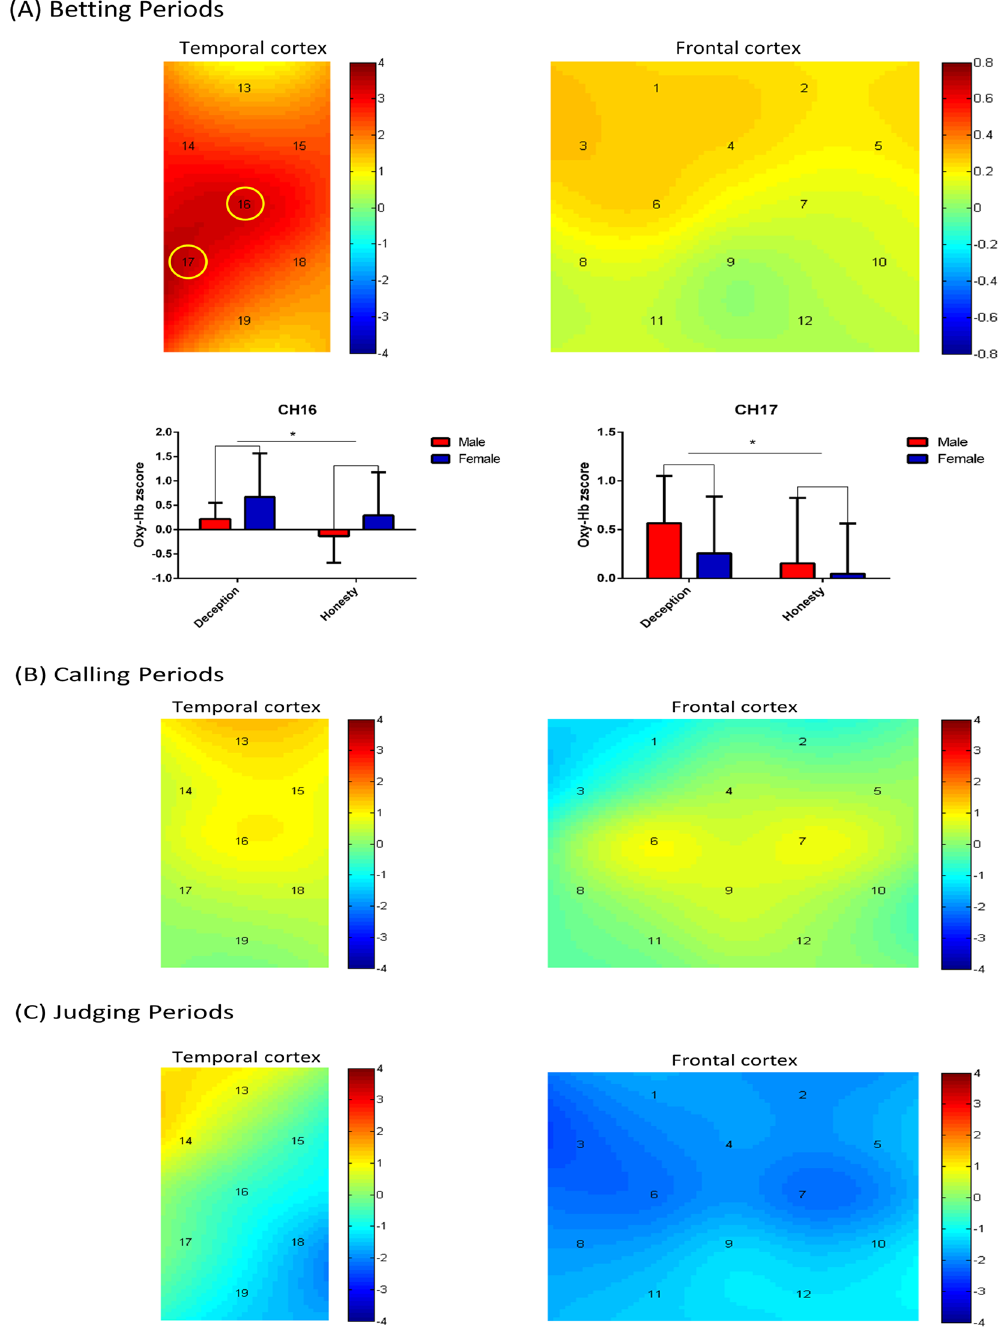
Figure 2. One-sample t-test of banker’s Oxy-Hb changes (deception compared with honesty) in ( A ) “banker” betting stage, ( B ) “follower” calling stage, and ( C ) judging stage, respectively. In the (A) “banker” betting stage, CH16 and CH17 (mainly covering TPJ) showed significantly higher activation in deception conditions ( * P < 0.05). Error bars indicate standard errors. (FDR corrected). [Color bar represent t